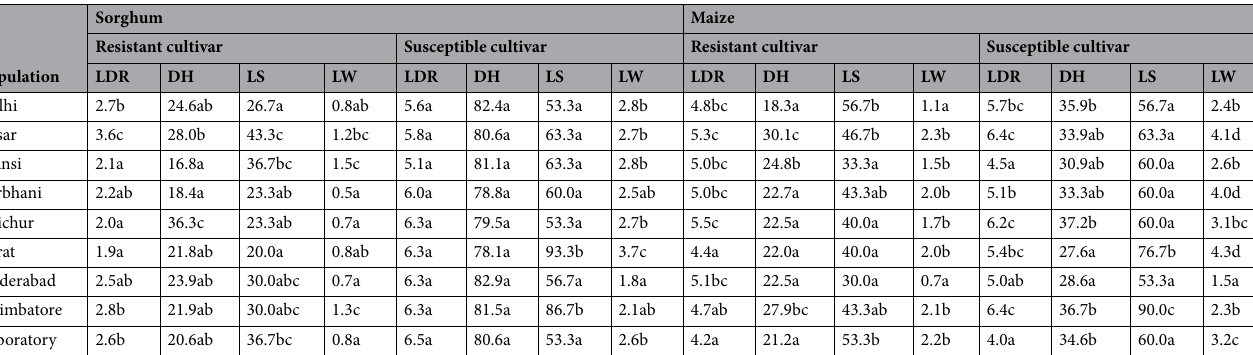
Table 2. Damage due to Chilo partellus on resistant and susceptible sorghum and maize genotypes, and larval survival and weight of different geographical populations. LDR Leaf damage rating (1–9), DH Deadhearts (%), LS Larval survival (%), LW Larval weight (mg/larva). The values in a column following different letters are significant at P = 0.05 using post-hoc Tukey’s HSD